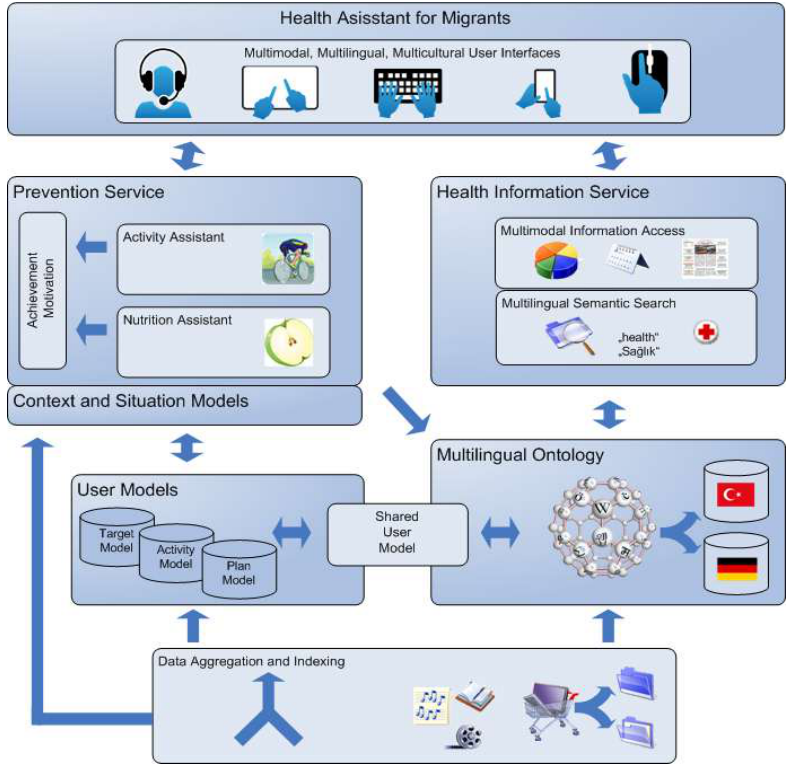
Figure 2. Overview of the system architecture of the IHA.